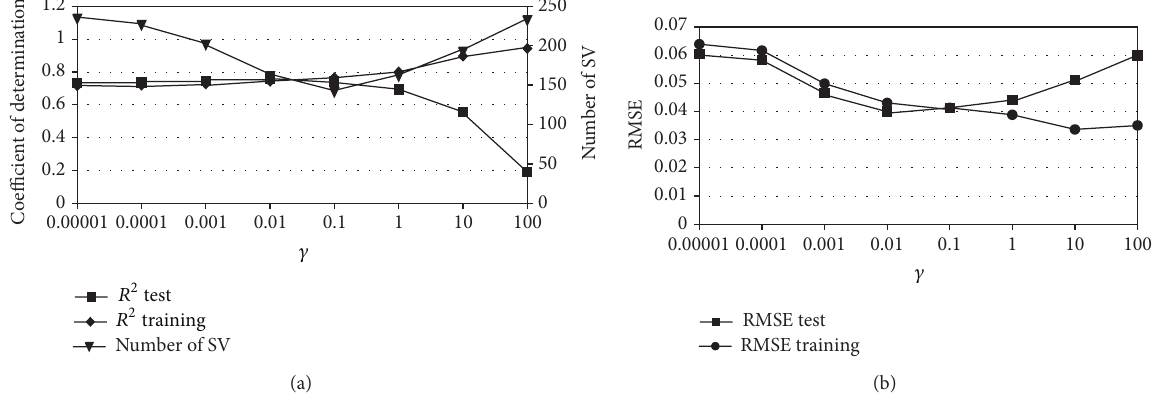
Figure 2: Example of the overfitting phenomenon for the radial basis kernel based 𝐶 -SVM model.